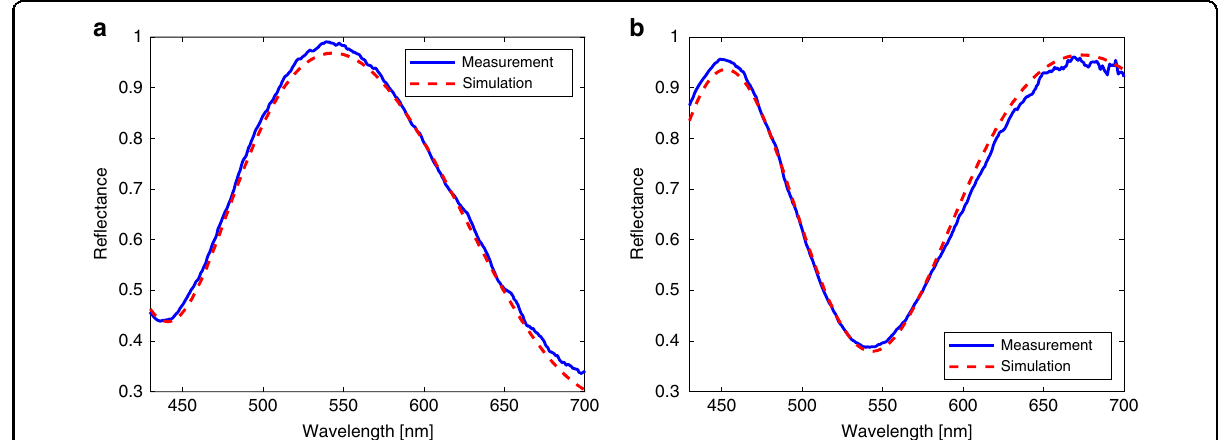
Fig. 6 Experimental results measured by the MASR system. a Results for the SiO 2 Film #1 487.1 nm obtained by the MASR system with a root mean square error (RMSE) = 0.0015 (Reference: 494.4 nm). b Results for the SiO 2 Film #2 391.3 nm obtained by the MASR system with an RMSE = 0.0022 (Reference: 392.1